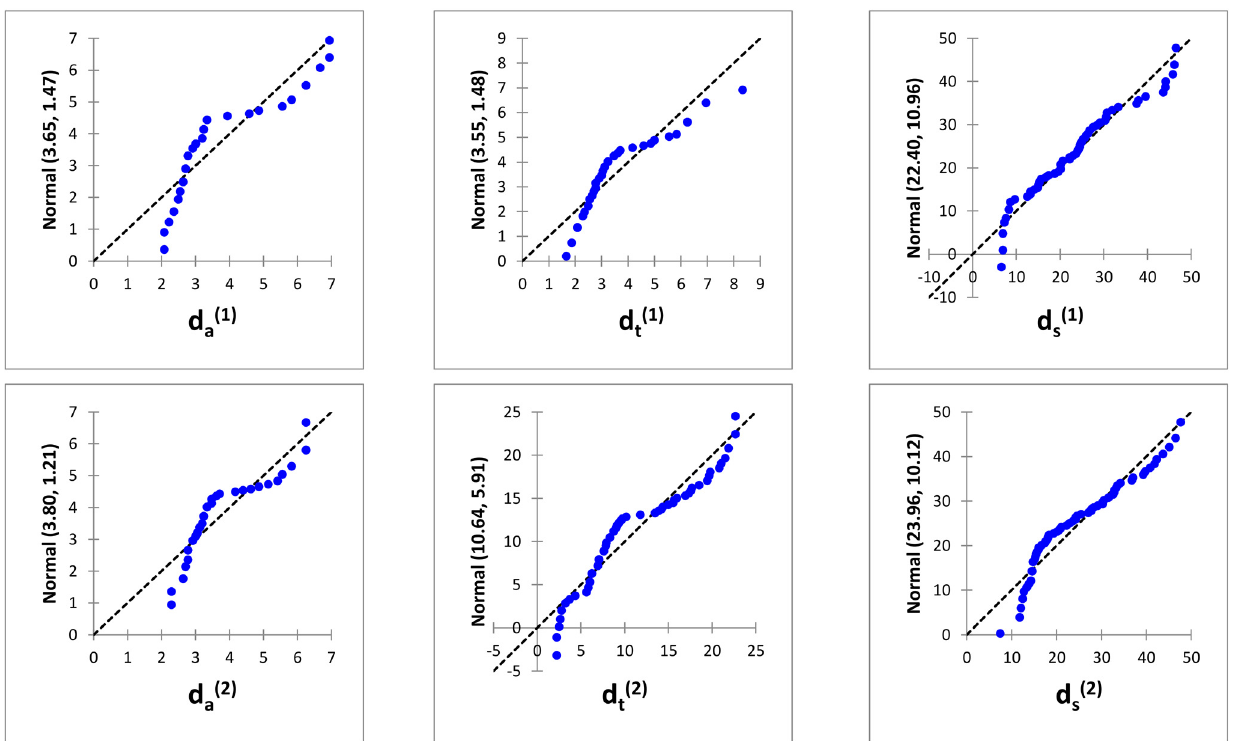
Figure 9. Q-Q plot of NiTi-1 and NiTi-2 alloy samples against Normal distribution.